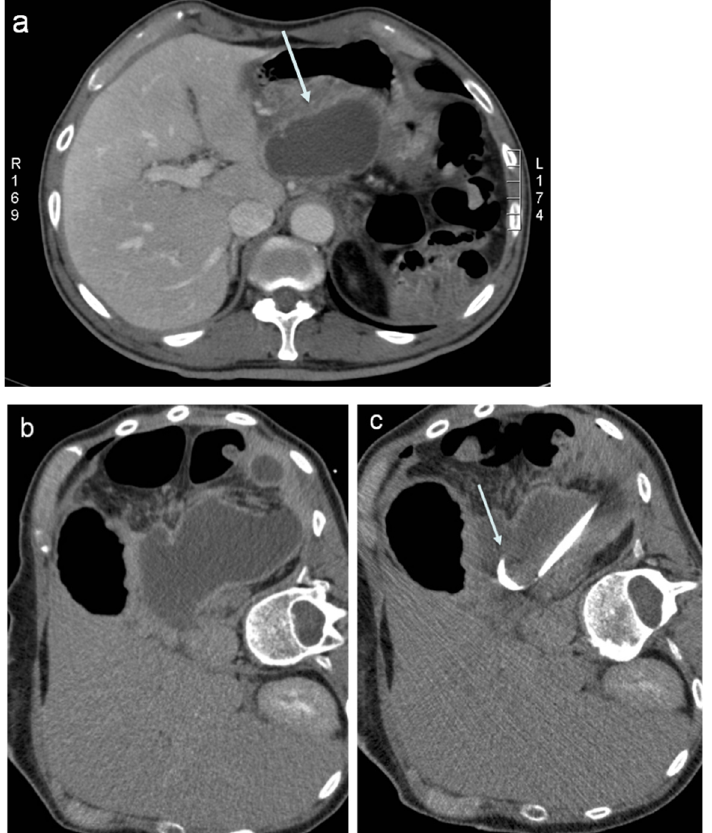
Figure 2. Fluid collection CT-guided drainage. ( a ) A contrast-enhanced CT showing a large, deep fluid collection after pancreatic surgery (arrow). ( b ) Patient positioning in the right lateral decubitus. ( c ) Percutaneous drainage (arrow) placed under TC guidance.